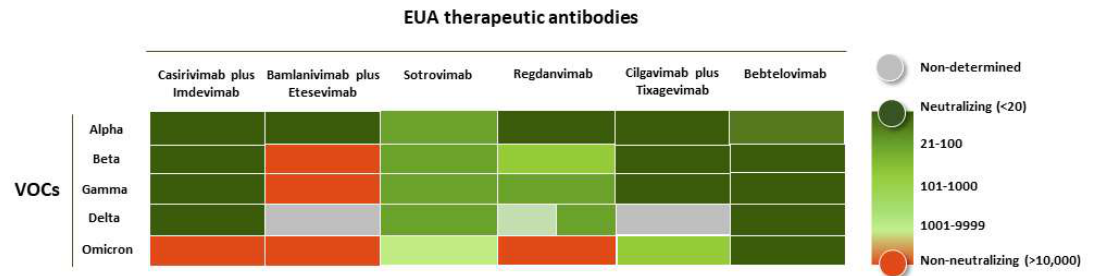
Figure 2. Neutralization potency of the EUA-approved anti-COVID-19 antibodies when challenged with SARS-CoV-2 VOCs. The heat map is based on the neutralization values of pseudovirus assays against SARS-CoV-2 variants [42–45]. The values of NC 50 in ng/mL are depicted in the following color code: <20 (dark green), 21–100 (hunter green), 101–1000 (lime green), 1001–9999 (light green), >10,000 (orange).